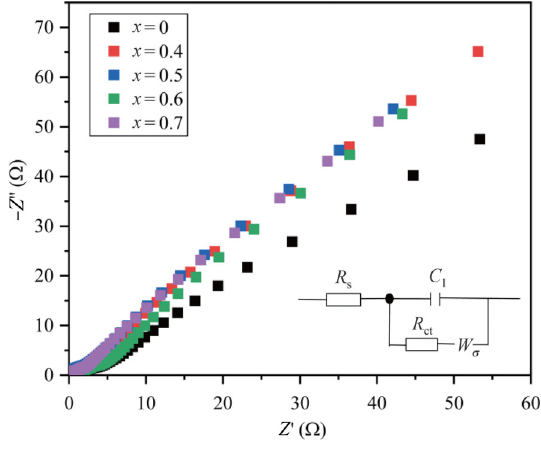
Fig. 10 Electrochemical impedance spectra of La(CoCrFeMnNiAl x ) 1/(5+ x ) O 3 − δ . Z ′ represents the real part of the impedance and – Z ″ represents the negative number of the imaginary part of the